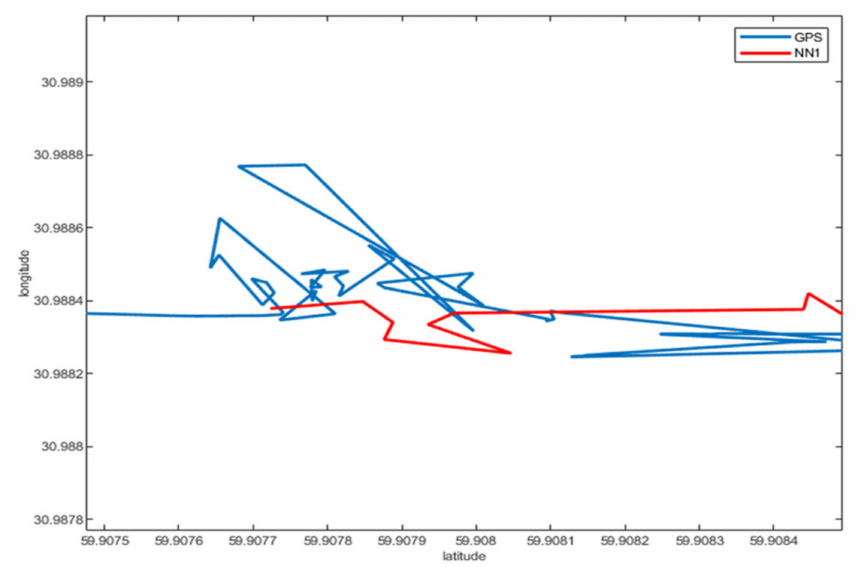
Figure 7. Comparison of the trajectory predicted by the neural network with the reference trajectory along the path with data loss and distortion.